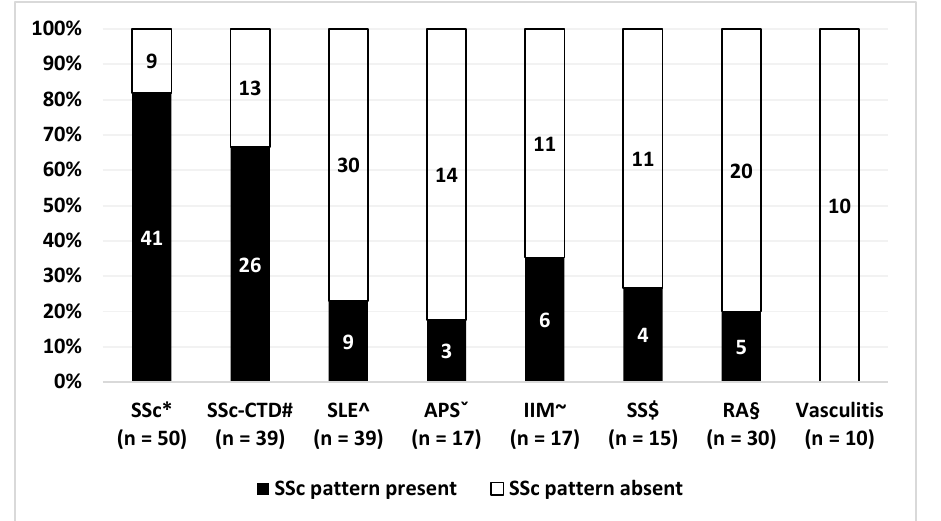
Figure 2. Prevalence of SSc pattern in different connective tissue disease groups: * SSc, systemic sclerosis; # SSc-CTD, systemic sclerosis overlap syndrome; ^ SLE, systemic lupus erythematosus; ˇ APS, antiphospholipid syndrome; ~ IIM, idiopathic inflammatory myositis; $ SS, Sjögren’s syndrome; § RA, rheumatoid arthritis. CD was significantly lower in patients with an SSc pattern in the case of SLE, APS, and RA but not in IIM or SS (Table 4). Table 4. Evaluation of capillary density in patients with and without SSc capillaroscopic